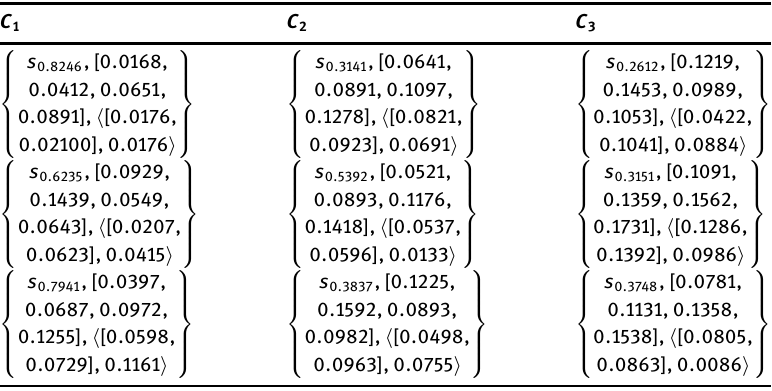
Table 5: The Weighted Normalized Trapezoidal Linguistic Cubic Fuzzy TOPSIS Decision Matrix. C 1 C 2 C 3